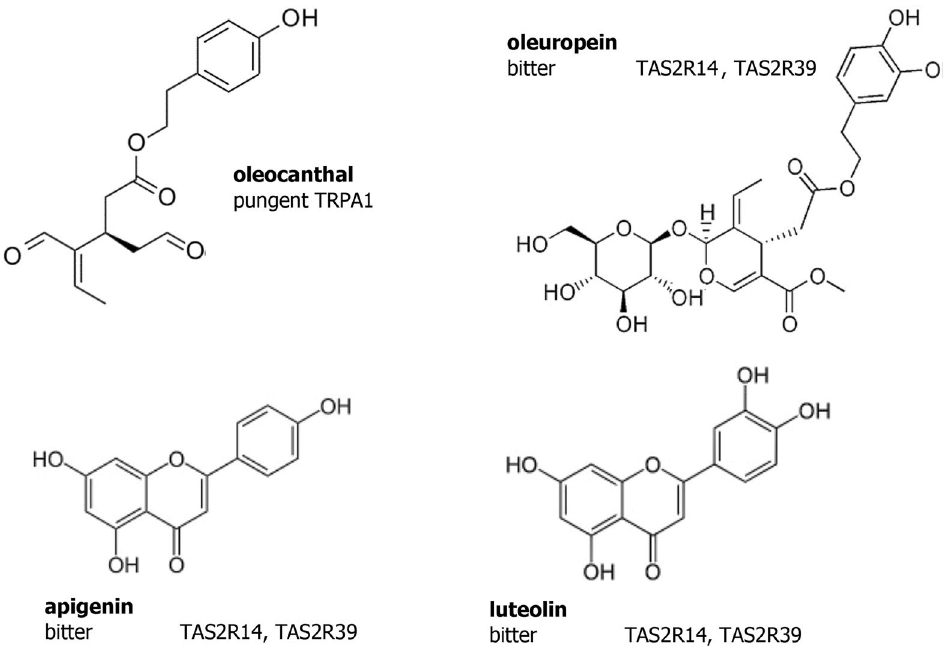
Figure 1. Chemical structures of endogenous compounds present in Extra-Virgin Olive Oil with their perceptual descriptors and the taste and sensory receptors by which the perceptions are mediated: oleocanthal (pungency in the throat, but not bitter), oleuropein (bitter, but not pungent), apigenin (bitter, but not pungent), and luteolin (bitter, but not